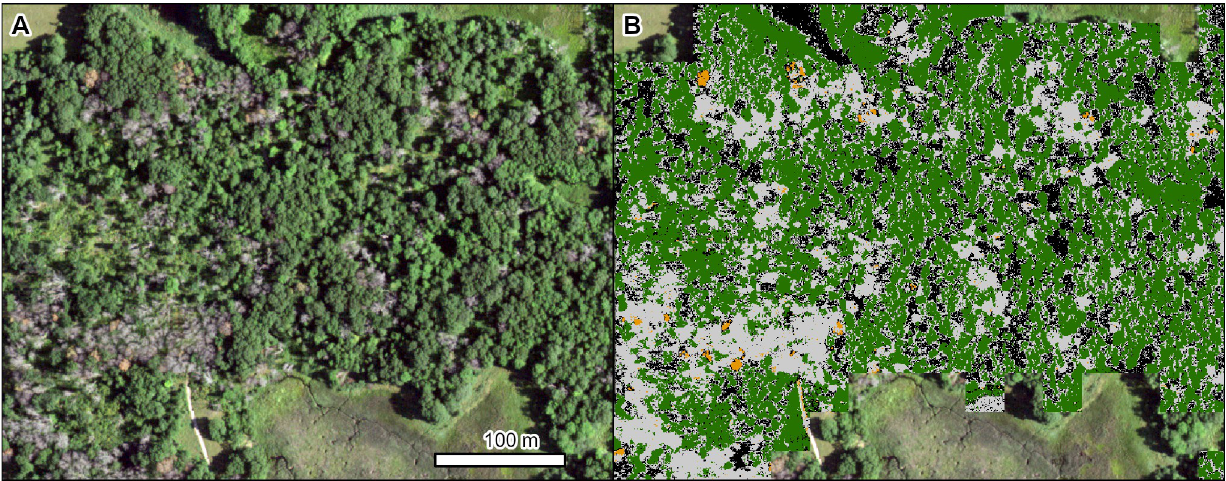
Fig 3. Mortality in a mixed stand of northern pin oak ( Quercus ellipsoidalis E. J. Hill) and northern red oak ( Q . rubra L.) caused by oak wilt ( Bretziella fagacearum ). (A) NAIP imagery from 2019. (B) TCH model results (orange = red crowns, light gray = gray crowns, dark green = green crowns, black = shadowed crowns). Location: North of Minneapolis, Minnesota. Insect and Disease Survey database DAMAGE_AREA_ID: {e3260d8f-6e10-4eb1- 8e51-23e4a3105d7b}. NAIP imagery (public domain) provided by